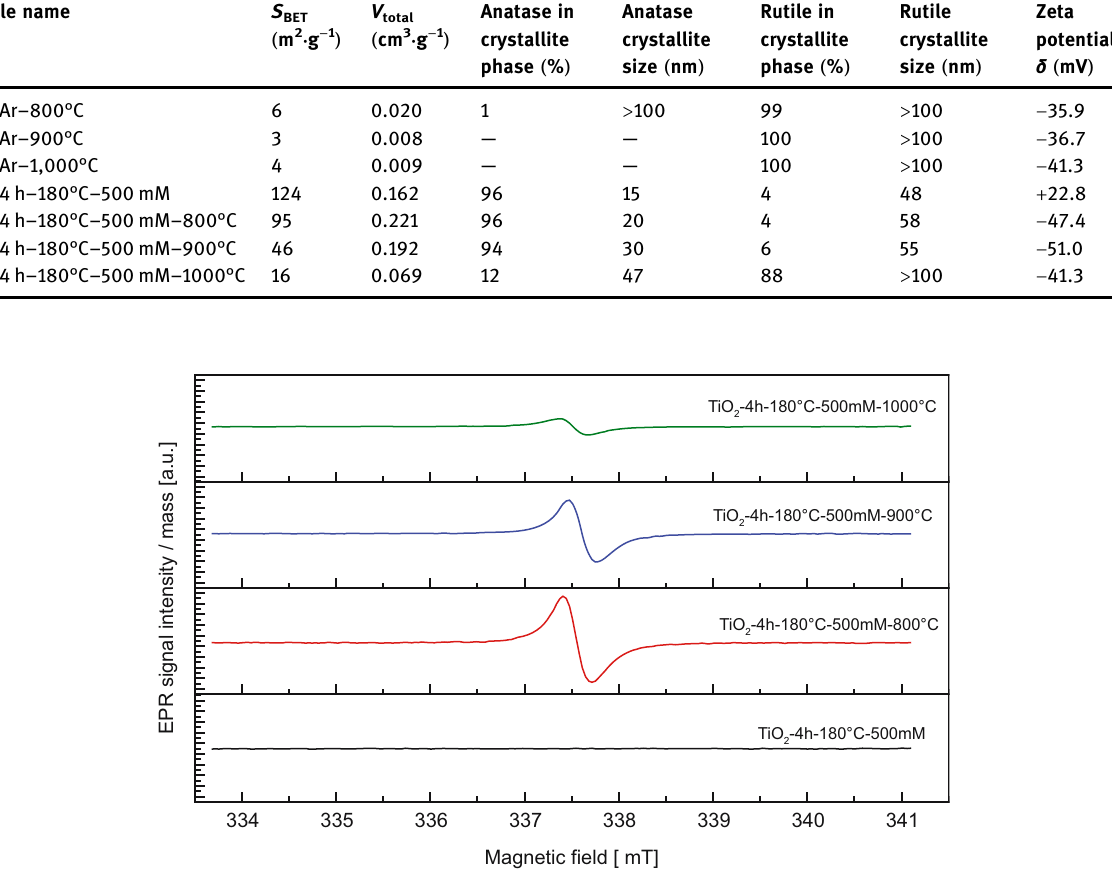
Figure 2: EPR spectra measured at RT of the uncalcined TiO 2 – 4 h – 180°C – 500 mM, and annealed TiO 2 – 4 h – 180°C – 500 mM – 800°C,